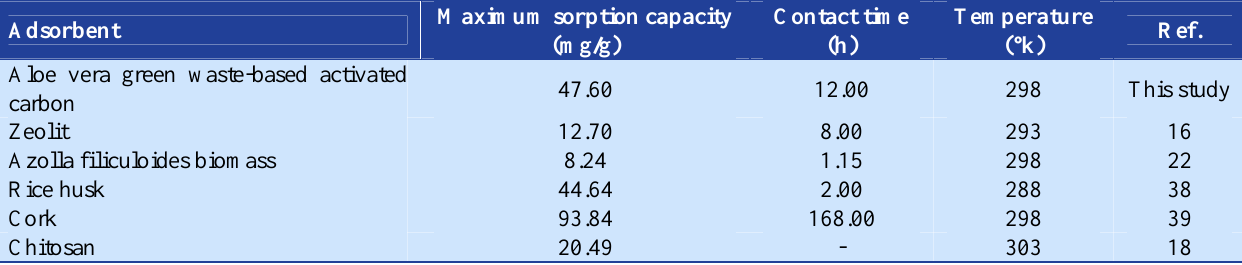
Table 3. Comparison of the maximum monolayer adsorption capacities of 4-CP with activated carbon from various adsorbents